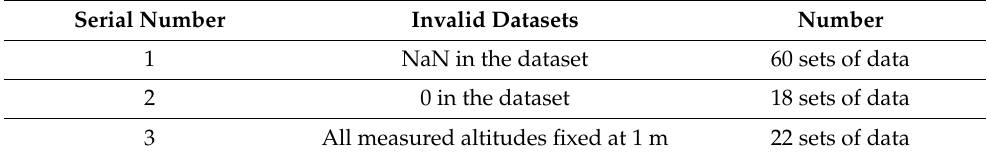
Table 2. The dataset preprocessing